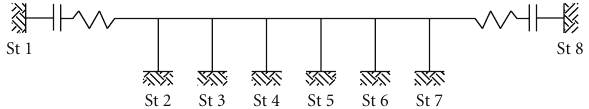
Figure 11: Ray of the 8 stations implemented in the FE model of the